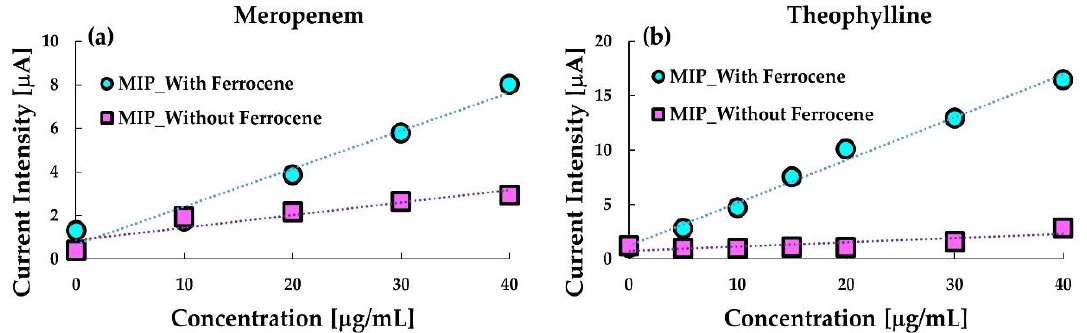
Figure 3. Calibration curves of ( a ) meropenem and ( b ) theophylline with the respective molecularly imprinted polymer (MIP) paste electrodes containing ferrocene in silicone oil (circles) or those without ferrocene (squares).